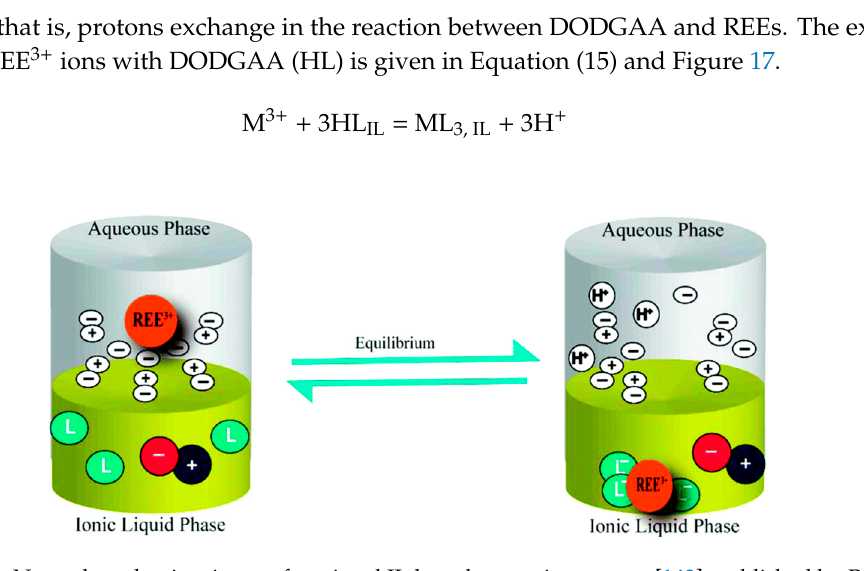
Figure 17. Neutral mechanism in non-functional IL-based extraction system [143]; published by Royal Society of Chemistry, 2017.